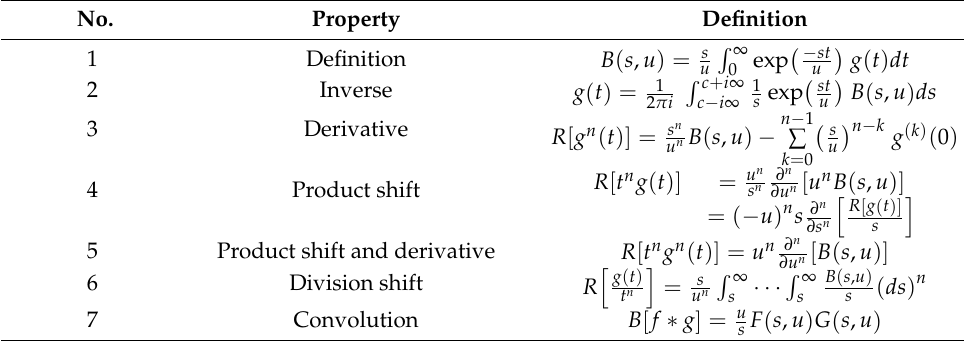
Table A2. General properties of Formable transform.